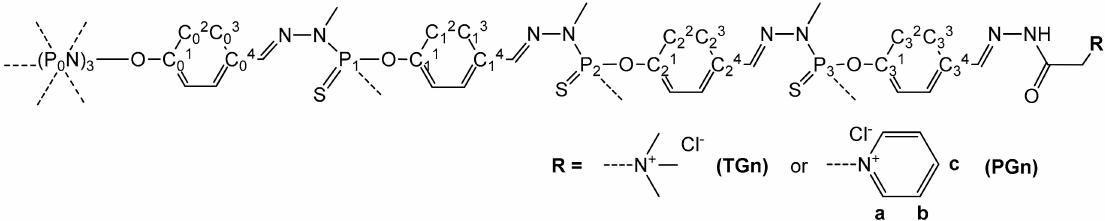
Figure 1. Atom numbering used for the NMR signal